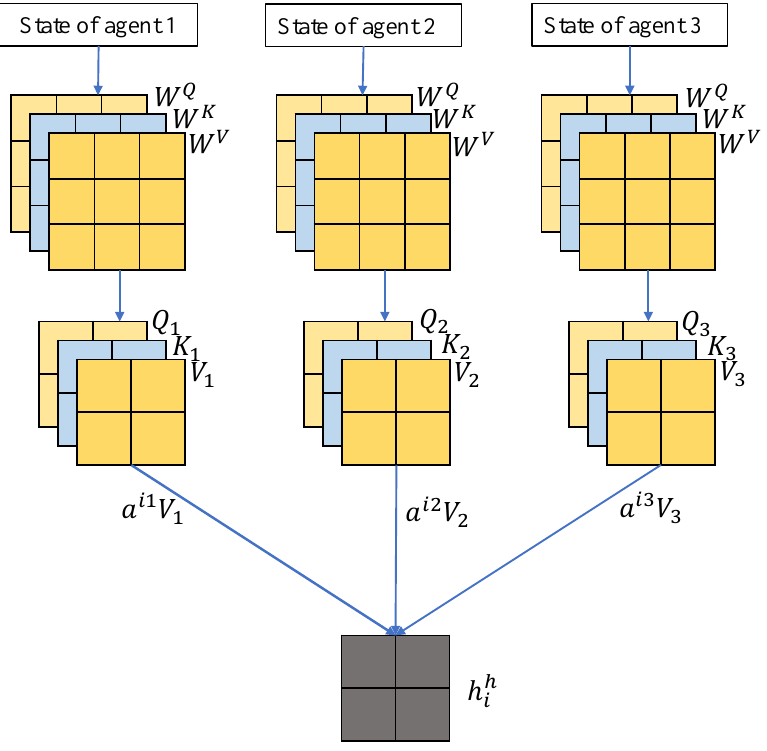
Figure 2. Architecture of one group attention. Suppose there are three agents around agent i in a group. State representations of agents in group h for agent i are aggregated according to attention coefficients a ij